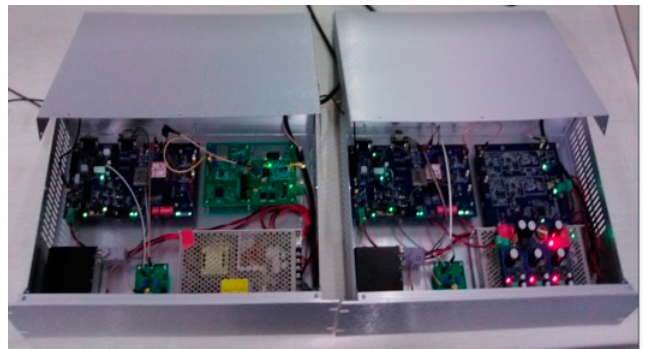
Figure 3. The internal configuration diagram of the transmitter and the receiver for the ASF correction system.